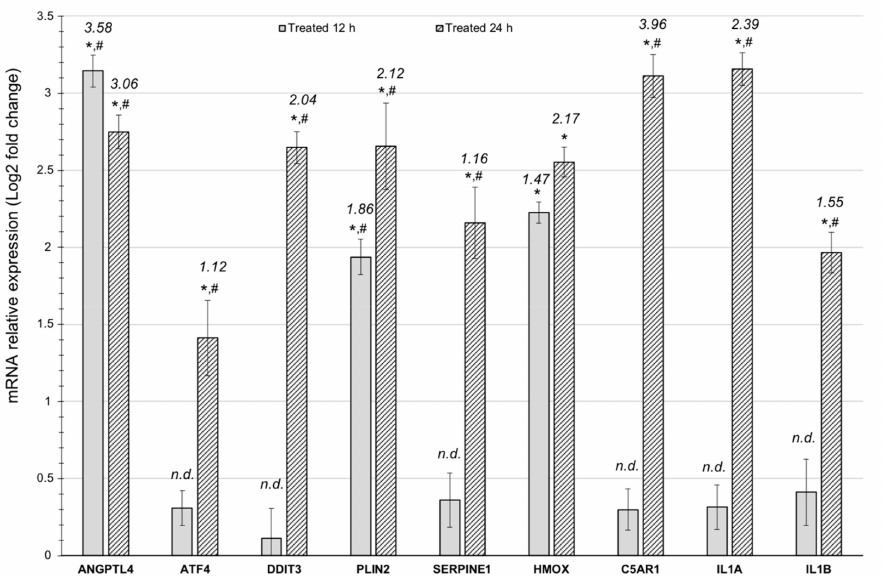
Figure 4. Quantitative RT-PCR validation of mRNA expression level. The results are expressed as the Log2 fold variation with respect to the corresponding control and GAPDH was used as a reference gene. Numeric values are the RNA-seq Log2 fold change values as per Supp. Table S2 for comparison; n.d. means that this gene was not di ff erentially expressed in the RNA-seq dataset at the 12 h timepoint. Data are the mean +/ – S.D. of three independent experiments; * means a significant di ff erence with a corresponding control with p < 0.001 and # means significative di ff erence between 24 h and 12 h treated timepoints with p <